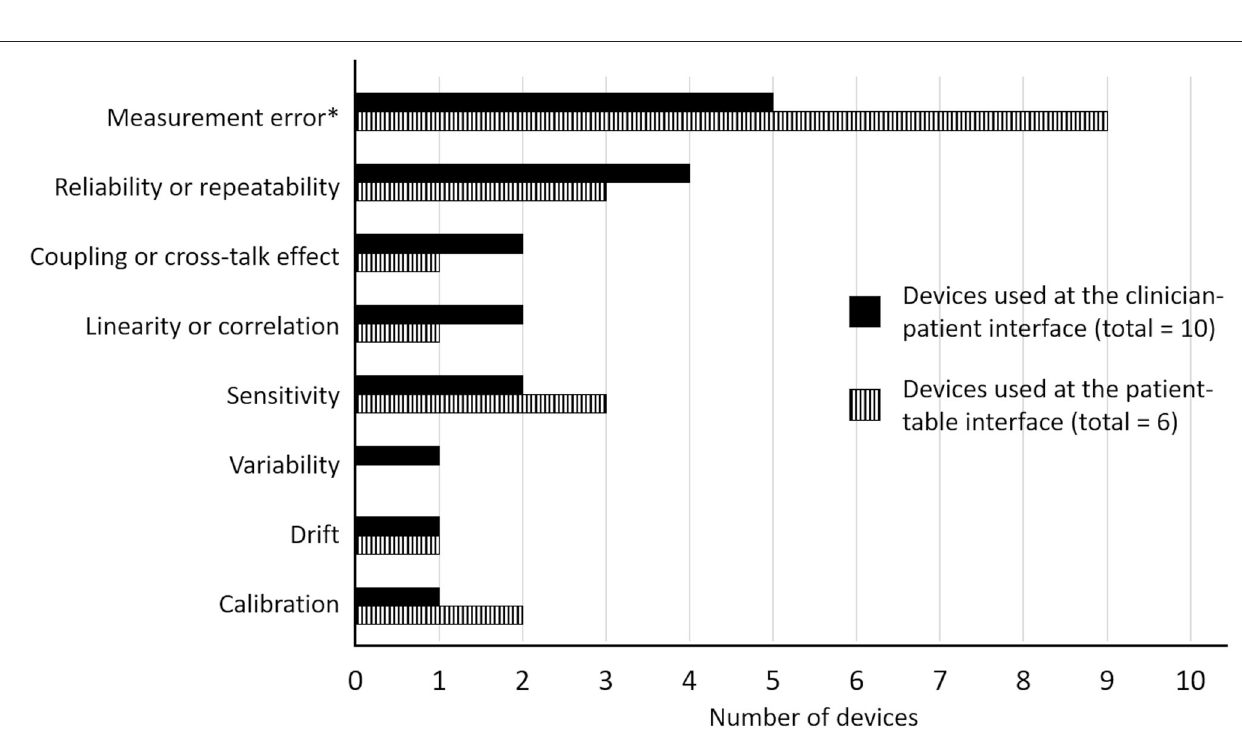
Frontiers in Pain Research |